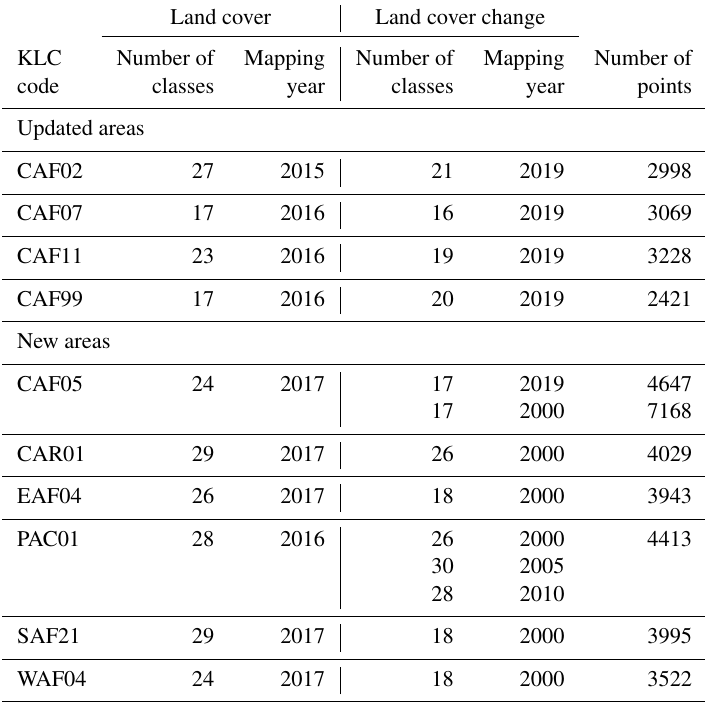
Table 3. Validation dataset attributes. Land cover Land cover change KLC Number of